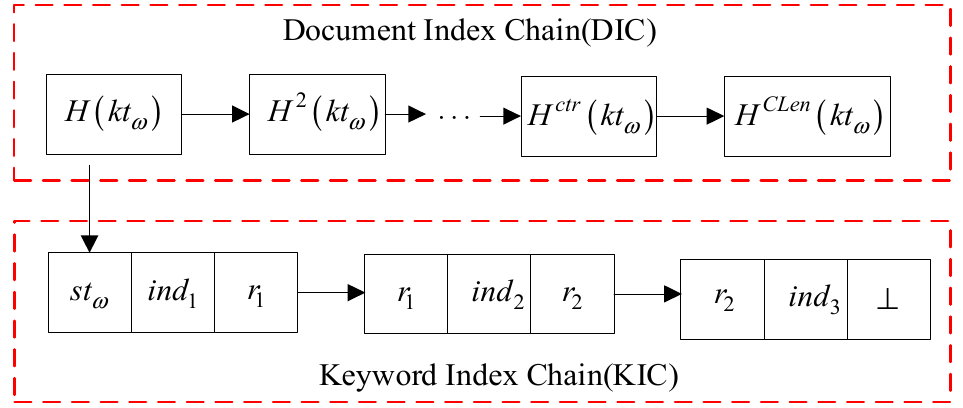
Figure 1. Double-layer structure.